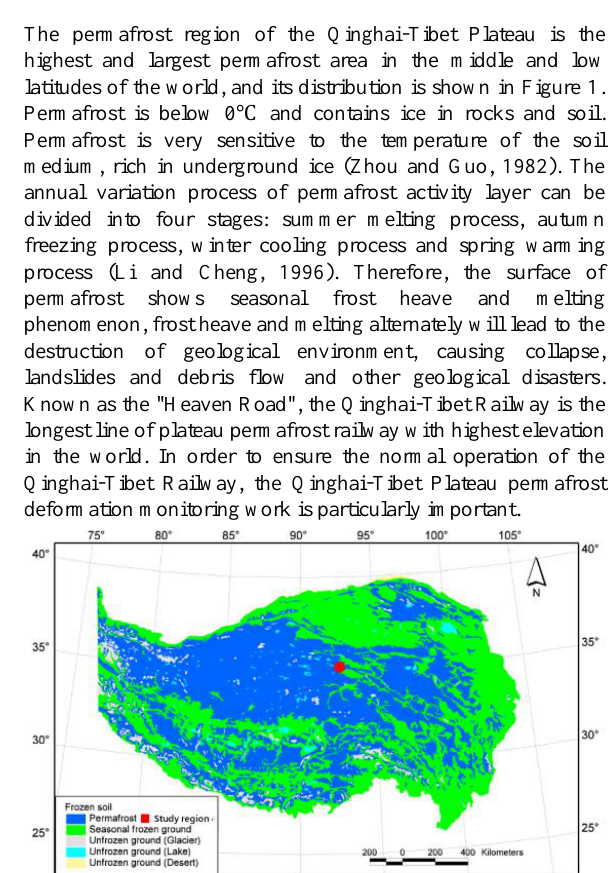
Figure 1 .Distribution pattern of permafrost in the Qinghai- Tibet Plateau (after Li and Cheng, 1996) The traditional method for deformation monitoring